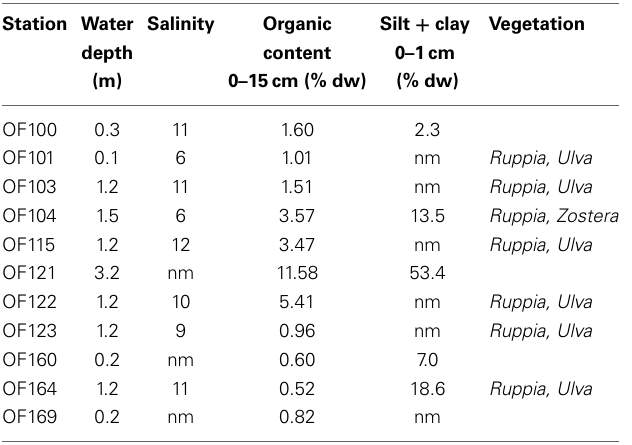
Table 1 | Key water column and sediment characteristics (nm = not measured) at representative sediment sampling stations in the inner part of Odense Fjord obtained during summer surveys in 2008 and 2010 (unpublished results).